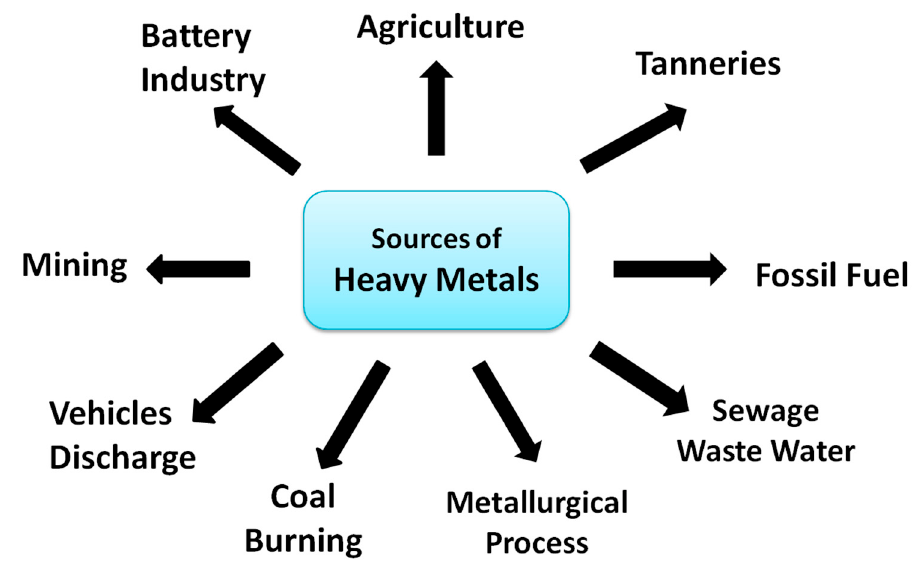
Figure 3. Sources of heavy metal contamination.